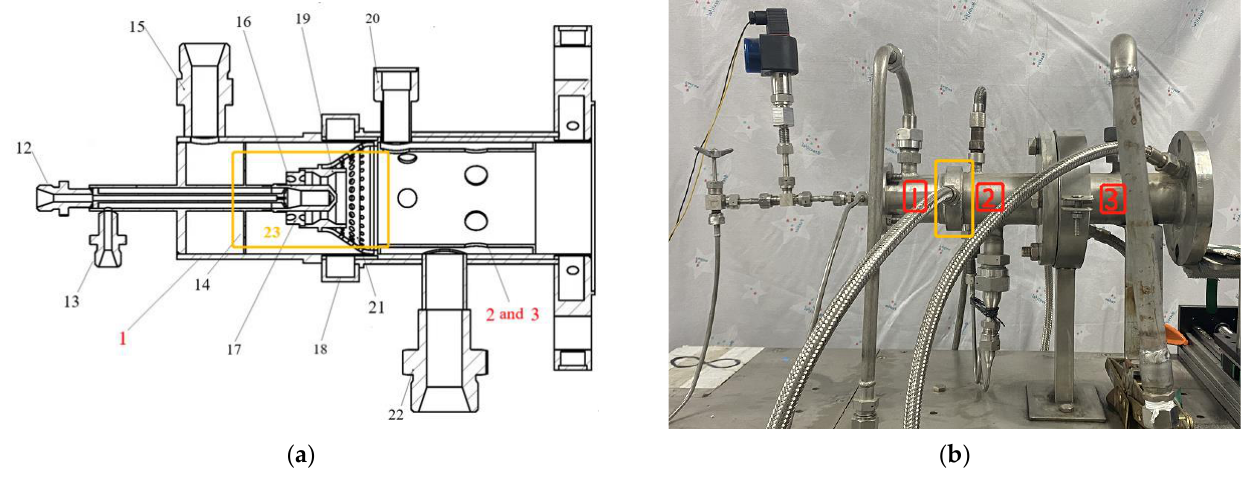
Figure 25. The combustion-gas generator: ( a ) Structure diagram; ( b ) Actual picture. 1, Air equalizing chamber; 2, The primary combustor; 3, The secondary combustor/mixer; 12, Kerosene inlet; 13, Atomization air inlet (the first stage atomization); 14, Uniform flow orifice; 15, The primary air inlet; 16, Atomization nozzle; 17, Air swirler; 18, Liquid trap; 19, Flame stabilizer; 20, Igniter; 21, Air equalizing cone; 22, The secondary air inlet; 23, The two-stage atomization device.